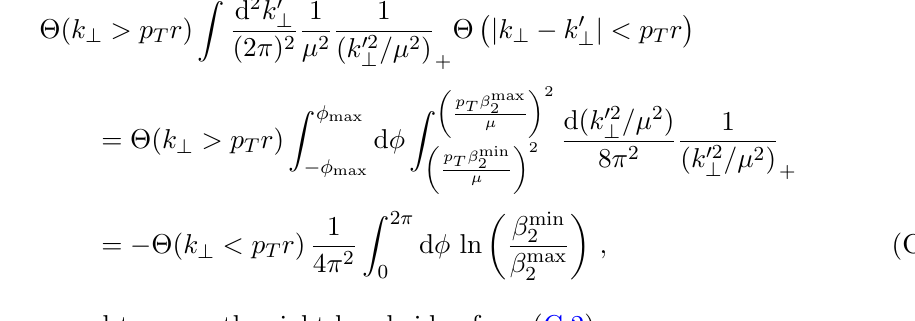
k k 0 < p T r for j ? (cid:0) ? j